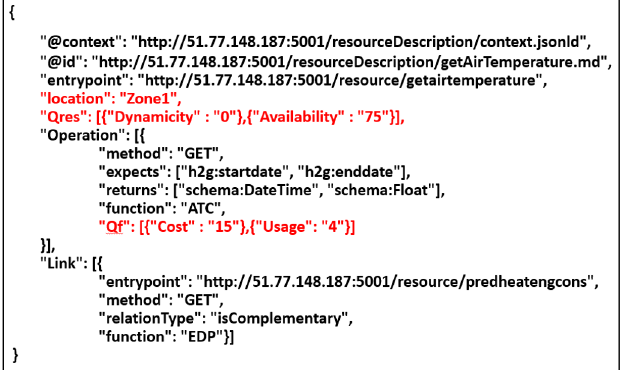
Figure 3. Example of an extended Hydra-based resource